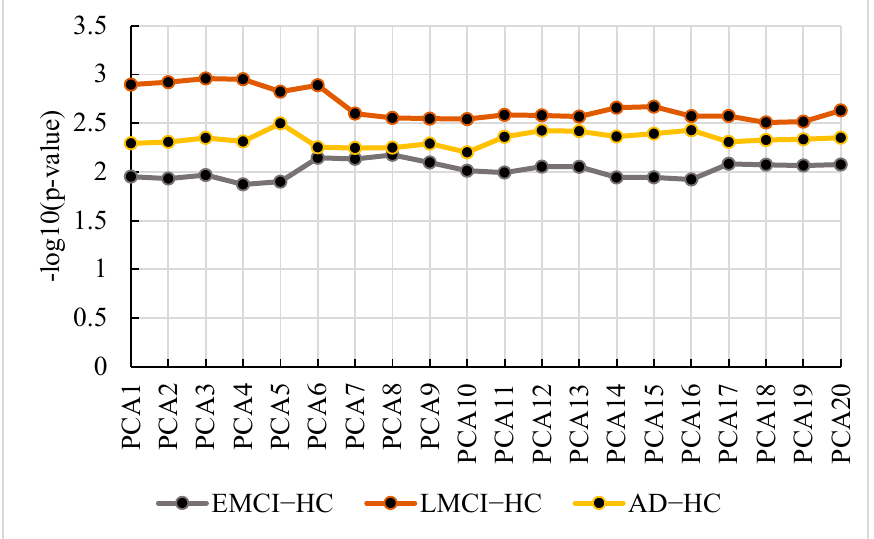
Figure 12. The p -value and PCA number in S AD − HC , S LMCI − HC and S EMCI − HC . From Figure 12, we find the optimal PCA number in S AD − HC , S LMCI − HC and S EMCI − HC is 5, 3 and 8, respectively. Using the selected number, we performed GWAS in each group and calculated p -values for genes. Then, we applied the genes with corrected p -values < 0.001 (Bonferroni corrected) for pathway analysis. We selected the pathways with corrected p -value < 0.01 in each group. The pathways and their corrected p -value of each group are shown in Figure 13 [22] and the top 20 genes in 3 groups are shown in Figure 14. Figure 13. The pathways with corrected p -value < 0.01 of the EMCI − HC group, LMCI − HC group and AD − HC group.